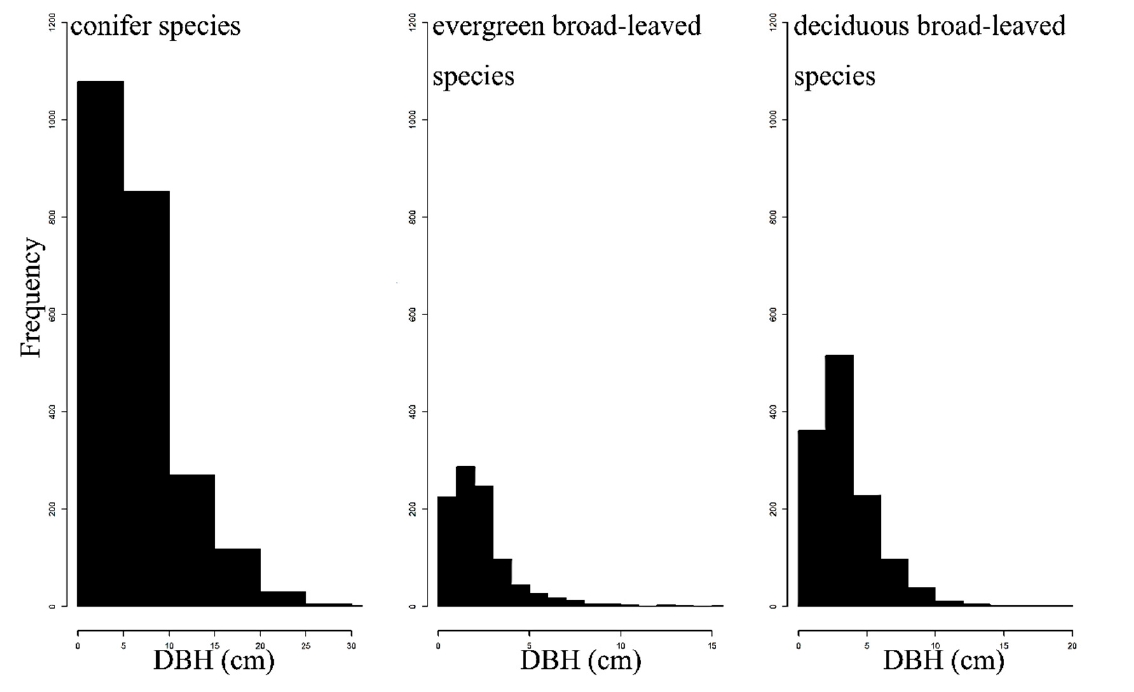
Figure 1. Diameter structure of broad-leaved (deciduous or evergreen) and coniferous species in the mixed forest community.